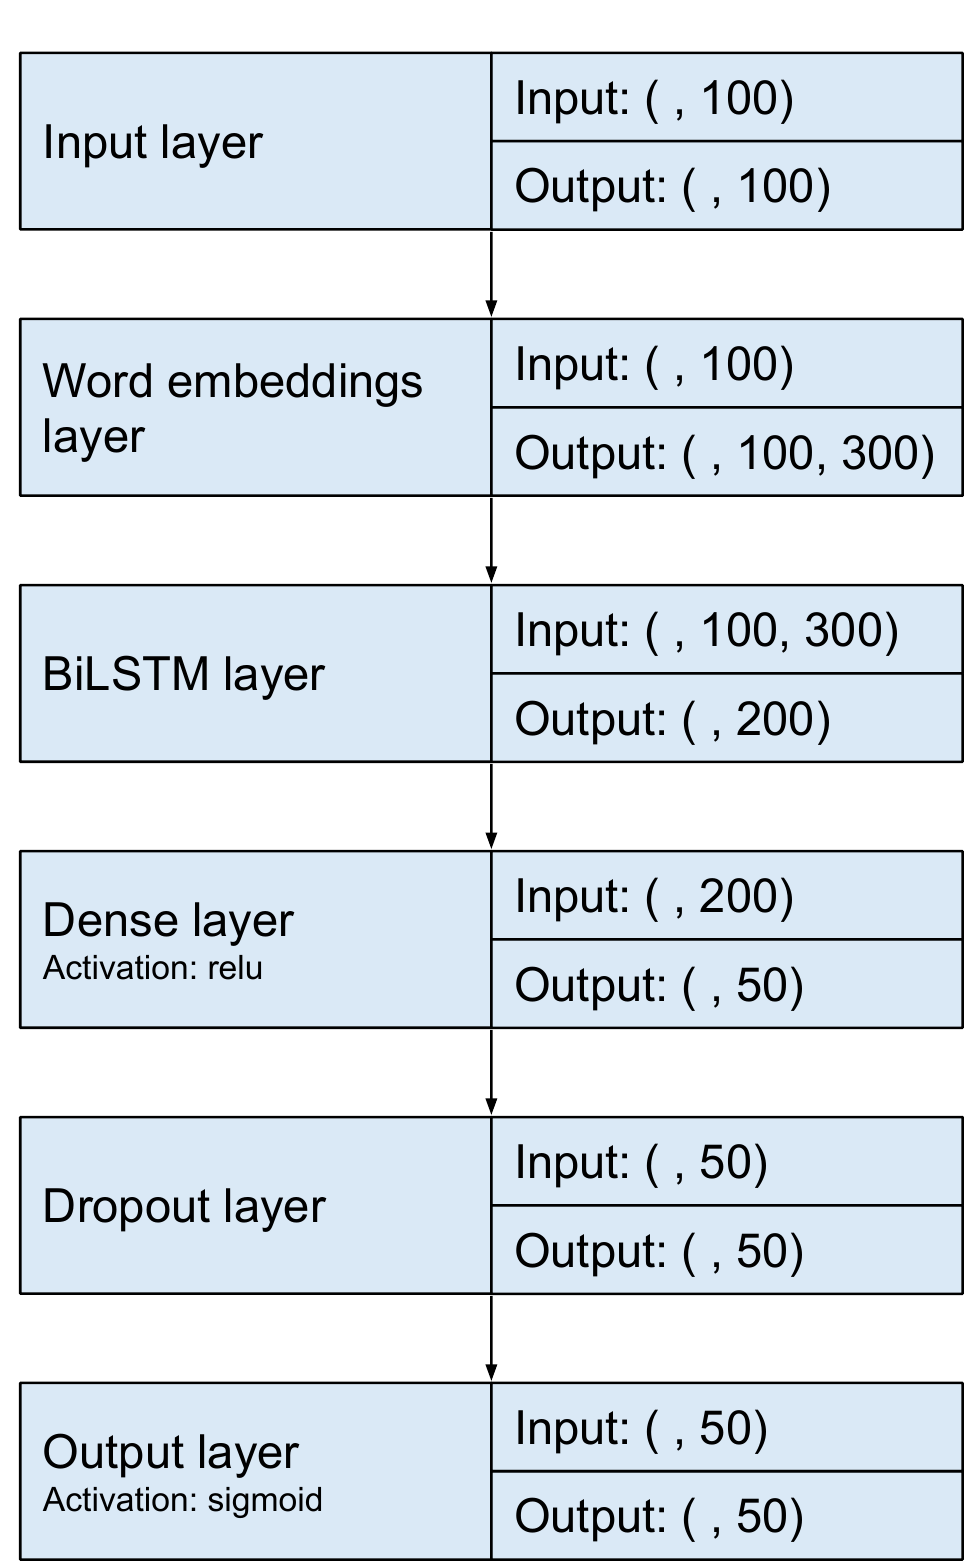
Figure 2. BiLSTM